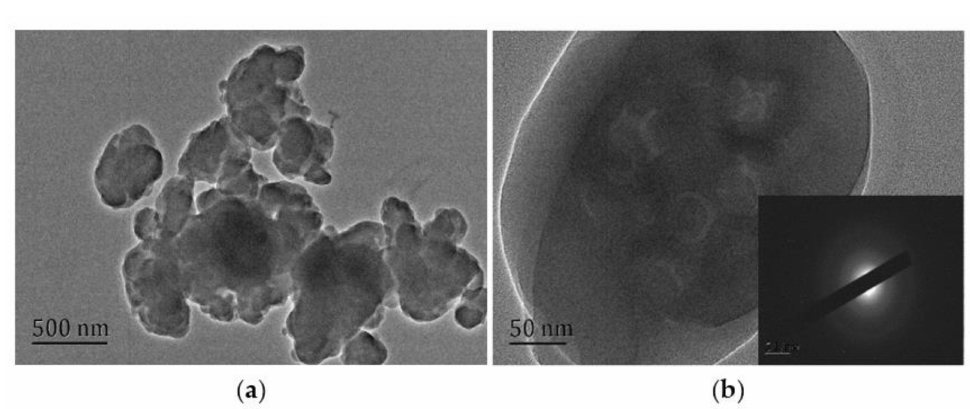
Figure 6. Transmission electron microscope (TEM) and selected area electron diffraction (SAED) images of curing UF resin (F/U = 1.0, 3% NH 4 Cl). ( a ) TEM images of resin particles, ( b ) ED patterns of resin